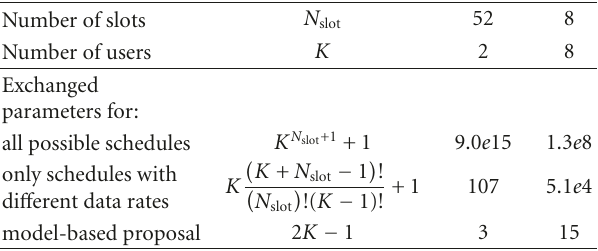
Table 1: Number of exchanged